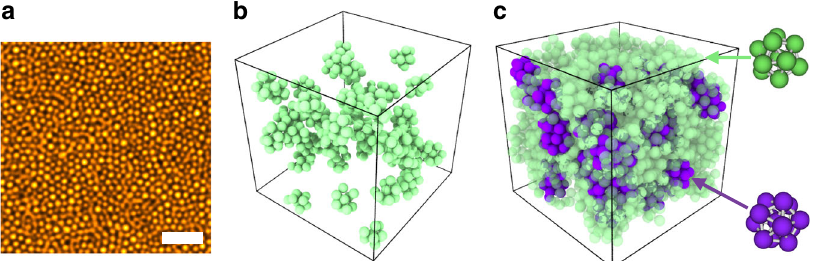
Fig. 1 Resolving small colloids in real space. a STED nanoscopy image for volume fraction 0.598. Scale bar = 3 μ m. b , c Rendered coordinates of defective icosahedra (green, top right structure) and full icosahedra (purple, bottom right structure) for volume fractions 0.523 ( b ) and 0.598 ( c